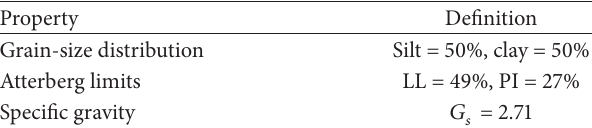
Table 1: Index properties of Pearl clay